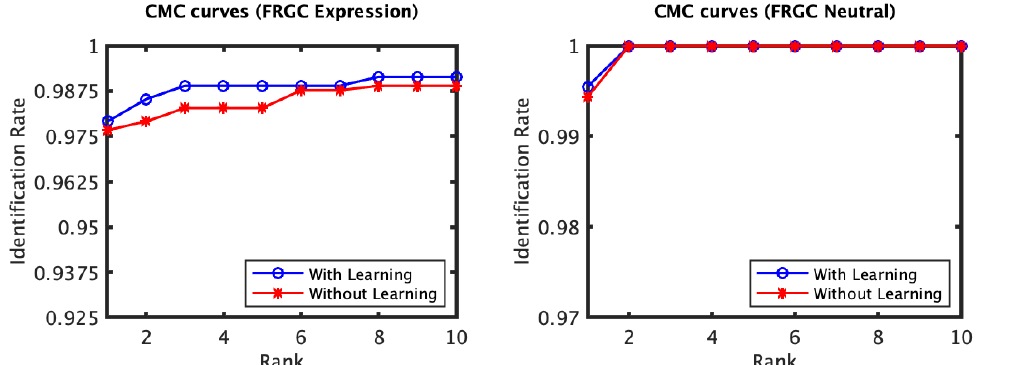
Figure 3. The CMC curves of the non-neutral ( left ) and the neutral ( right ) subsets of the FRGC dataset which were spared for evaluation. The curves compare the performance when using the proposed learning approach based on the RAIK features to that when the RAIK features are used without learning. Both methods achieve a very high performance. However, a noticeable improvement is observed for the non-neutral scans in particular, especially for the first few ranks.